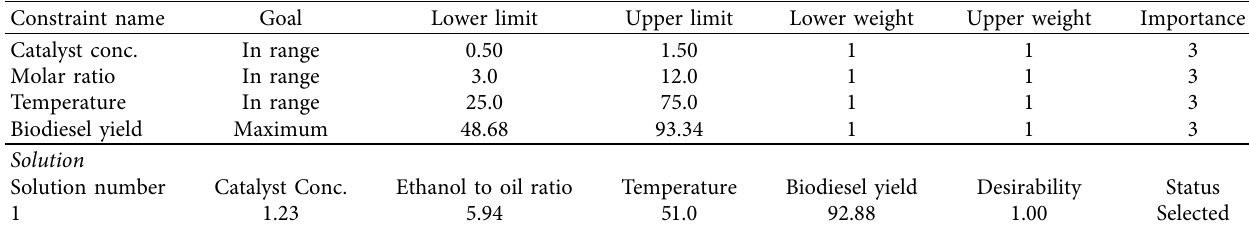
Table 6: Optimization of transesterification process variables under optimum conditions.